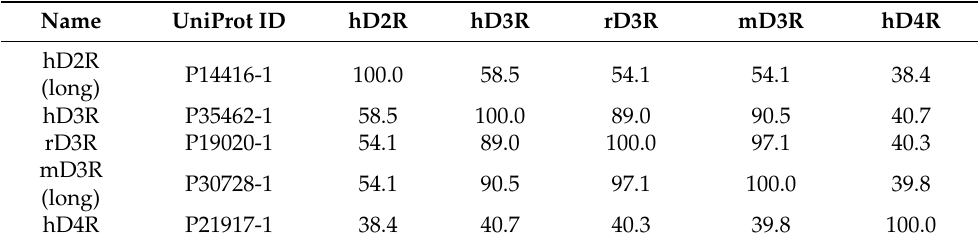
Table 1. Percent identity matrix of D 2 -like receptors of different species created by Clustal2.1 software [64]; h: human; r: rat; m: